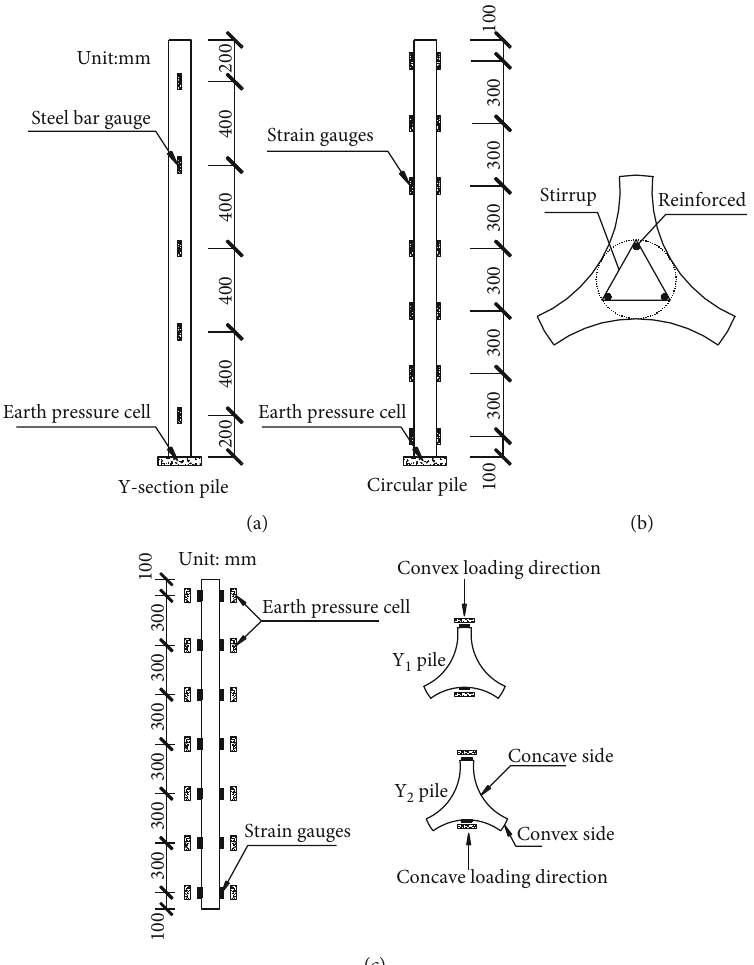
Figure 3: Instrumented model piles: (a) Y-shaped and circular piles under compressive load; (b) steel cage; (c) two Y-shaped piles under convex and concave horizontal loading direction.